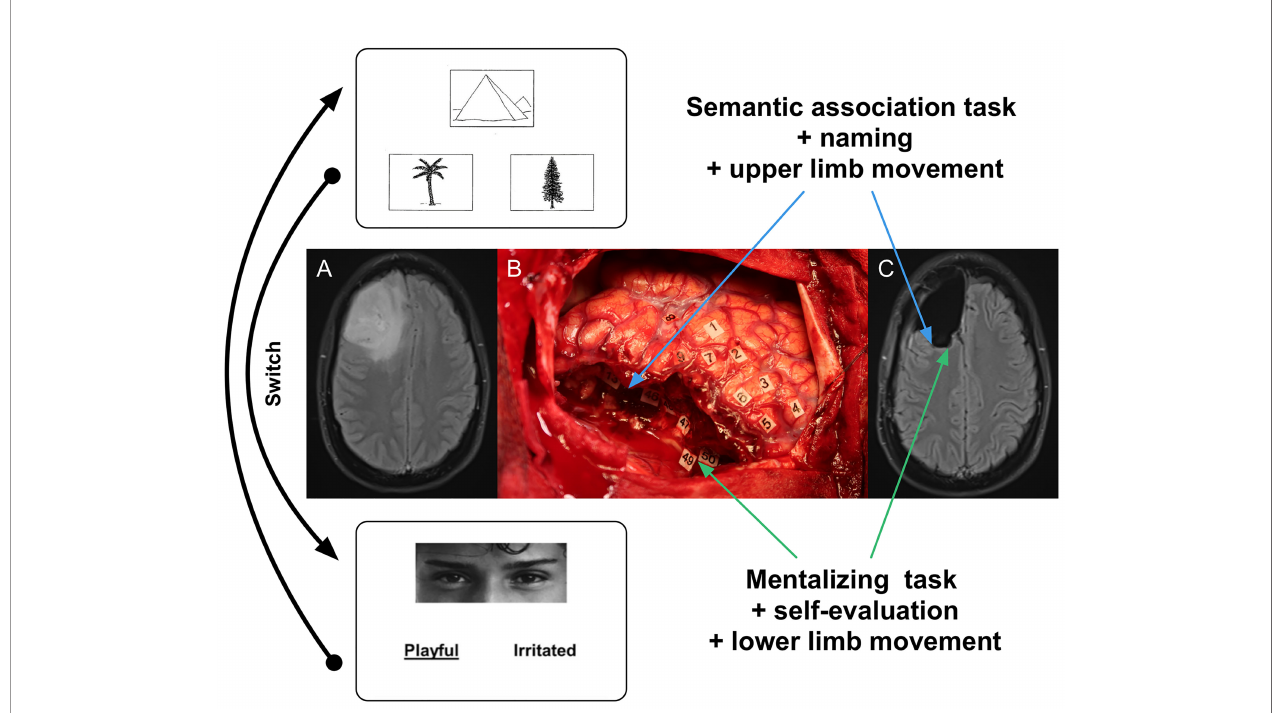
FIGURE 1 | Illustration of intraoperative constant multi-tasking adapted to the surrounding neural networks encountered throughout the resection. (A) Axial FLAIR-weighted MRI showing a right frontal LGG discovered in a 55-year right-handed man who experienced seizures. The preoperative neurological and cognitive assessments were normal. (B) Intraoperative view after surgical resection achieved up to functional boundaries in awake patient (the anterior part of the brain is on the left and its posterior part is on the right). Number tags show zones of positive DES mapping (2 mA) as follows: - tags 1, 2 and 8: ventral premotor cortex (lateral part of the precentral gyrus) generating anarthria during DES; - tag 3: primary motor cortex of the face, inducing involuntary facial movements during DES; - tag 4 and 5: primary motor cortex of the left upper limb, eliciting involuntary movements during DES; - tags 6 and 7: negative motor sites (anterior part of the precentral gyrus) generating arrest of both speech and movement of the left upper limb during DES; - tag 9: area involved in semantic processing, evoking PPTT (semantic association task) disturbances during DES. Subcortically, the resection was also performed according to critical networks detected in a patient achieving constant multi-tasking. First, the patient was asked to perform motor task combined with PPTT when removing the postero-lateral part of the tumor close to the frontal terminations of the inferior fronto-occipital fasciculus (tag 13, inducing semantic de fi cit during DES) as well the junction between the fronto-striatal tract (tags 46 and 48, generating arrest of movement during DES) and the pyramidal pathway (tag 47, eliciting involuntary movement of the left upper limb during DES) (blue arrows). Then, the patient was asked to switch to a mentalizing task (RME) combined with a self-evaluation test and a movement of the lower limb when removing the postero-mesial and deep part of the lesion close to the cingulate bundle: DES of the fronto-striatal tract (medial portion) induced arrest of movement of the lower limb (tag 50) while DES of the cingulate fi bers generated mentalistic de fi cits in a patient still able to move the lower limb (tag 49) (green arrows). (C) Axial FLAIR- weighted MRI performed 3 months after surgery, revealing a complete resection, in a patient able to resume an active familial and socio-professional life with neither neurological nor neurocognitive de fi cit. Blue and green arrows show the correlations between functional subcortical structures which induced transitory behavioral disturbances during DES and their anatomical positions on the postoperative